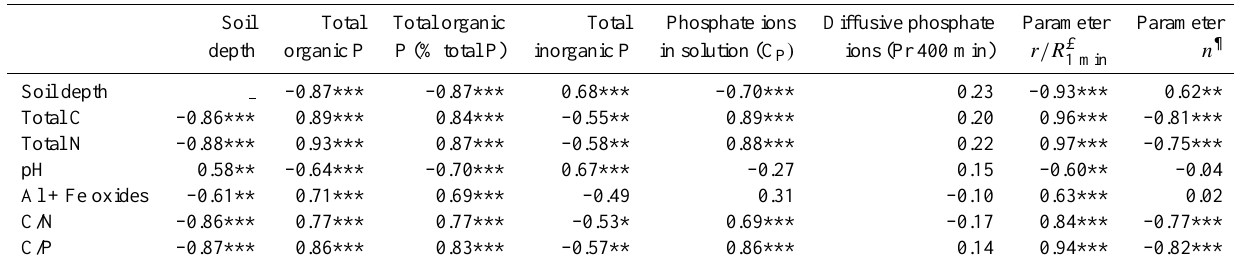
Table 2. Correlations between P status variables, physicochemical soil properties and soil depth (Pearson’s correlation coefficients; n obs = 45 mineral soils † )